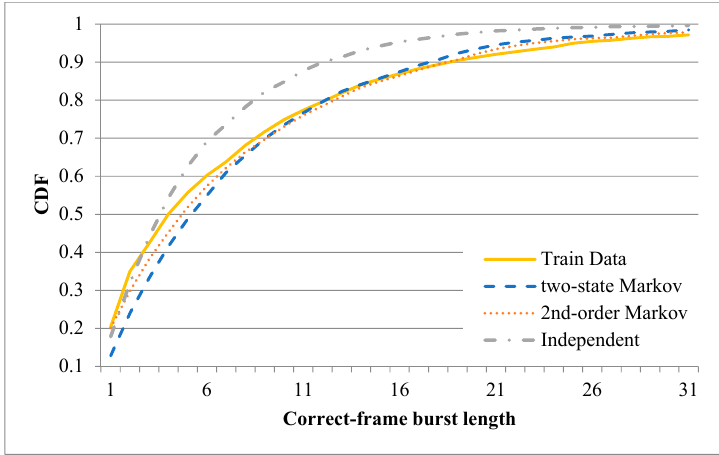
Figure 10. Training results for the second-order Markov model using: ( a ) records in the first minute of the sixth hour, and ( b ) records in the first minute of the tenth hour.